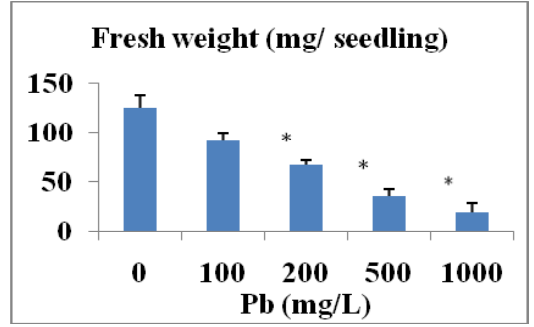
Fig. 1. Effect of lead on seedling growth in radish (Raphanus sativus). The averages of three replicates ± SE and (*) statistically significant at p<0.05